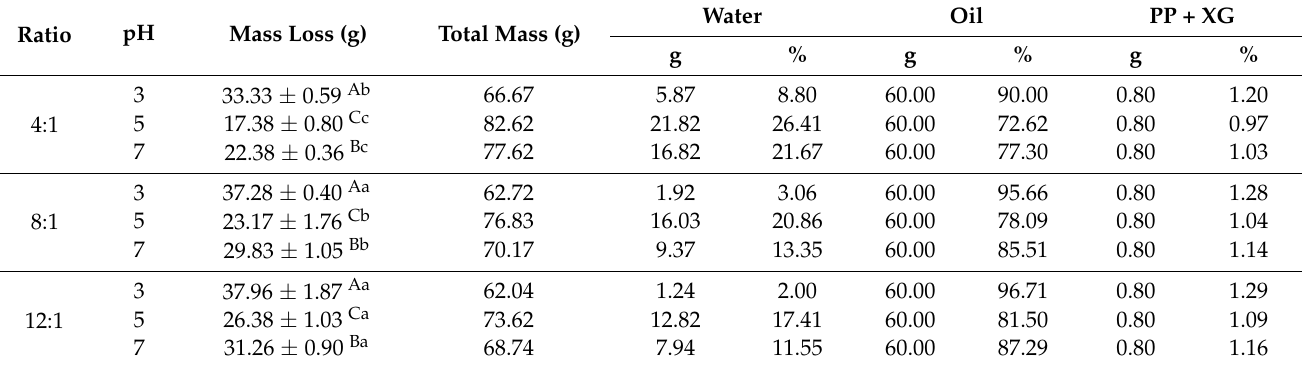
Table 1. Mass balance of HIPEs after emulsion drying (100 g of initial emulsion).